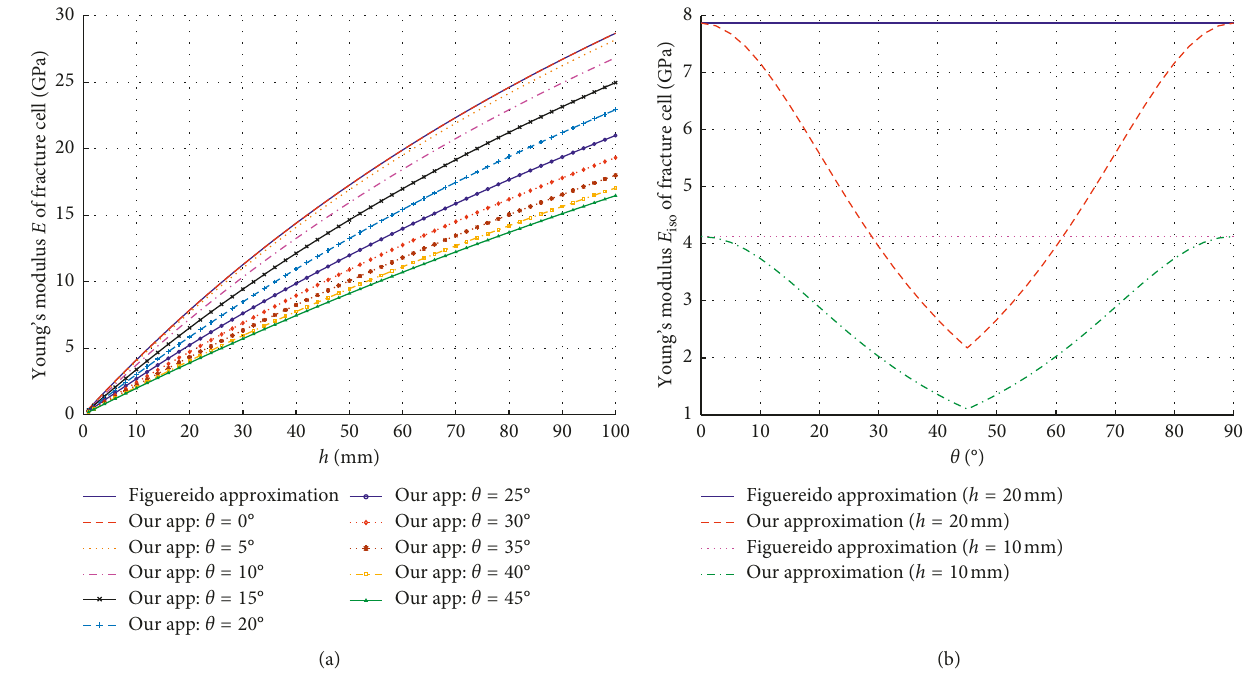
Figure 7: Young’s modulus of the fracture cell E iso calculated from the two isotropic approximations as function of the fracture cell size h (in mm) and inclination angle (in degrees) of fracture: (a) E iso versus h ; (b) E iso versus inclination angle of fracture.